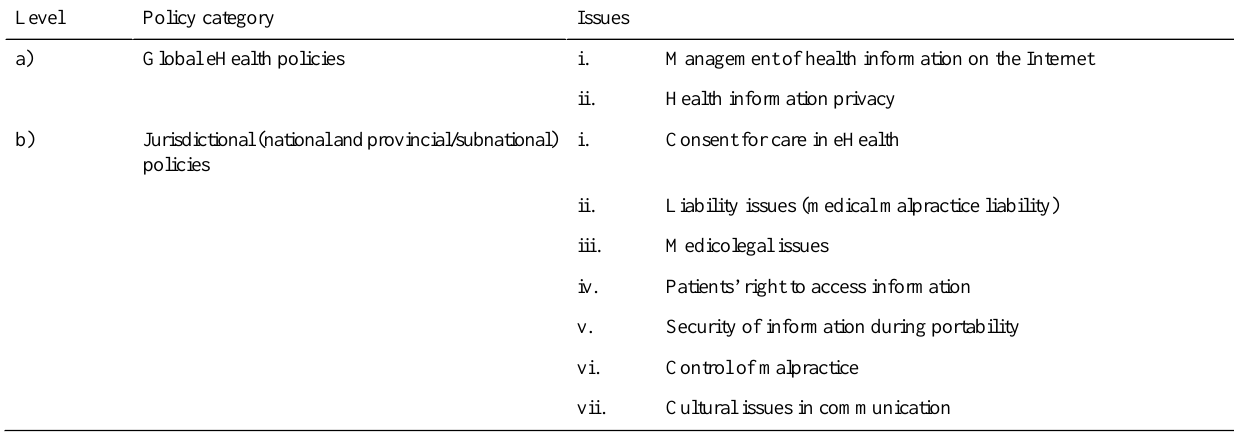
Table 9. Ethical and legal issues in